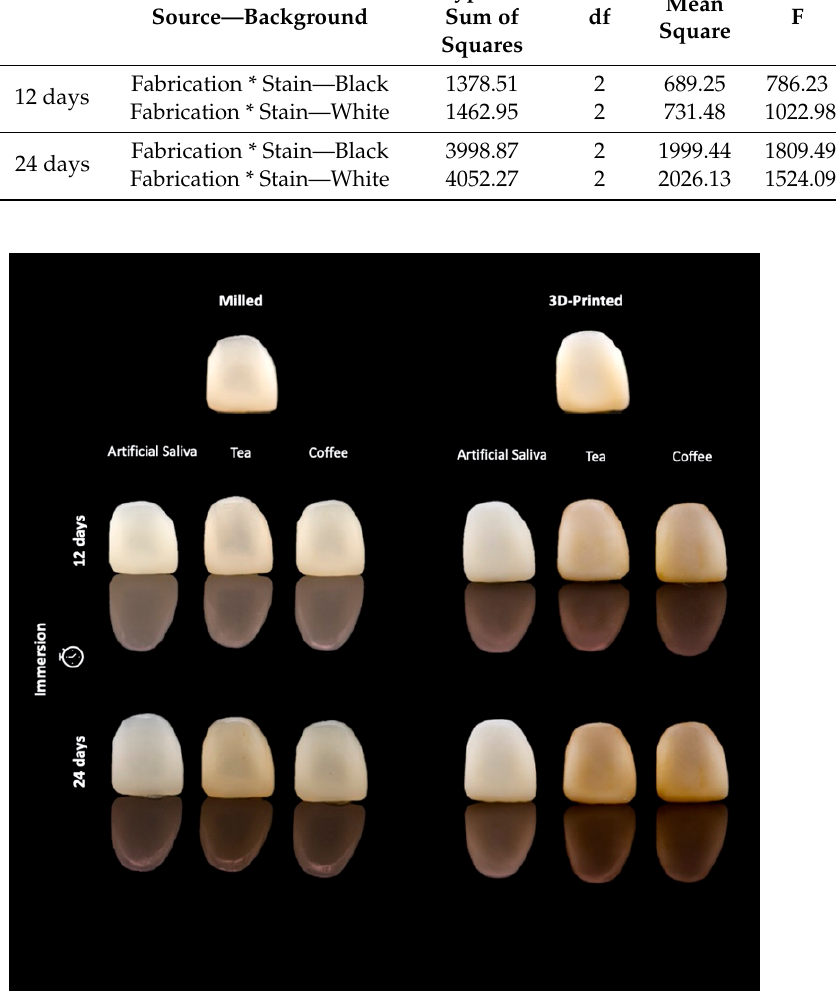
Figure 2. Photograph of ∆ E 00 of stained milled and 3D-printed specimens after 12 and 24 days of immersion in staining mediums.